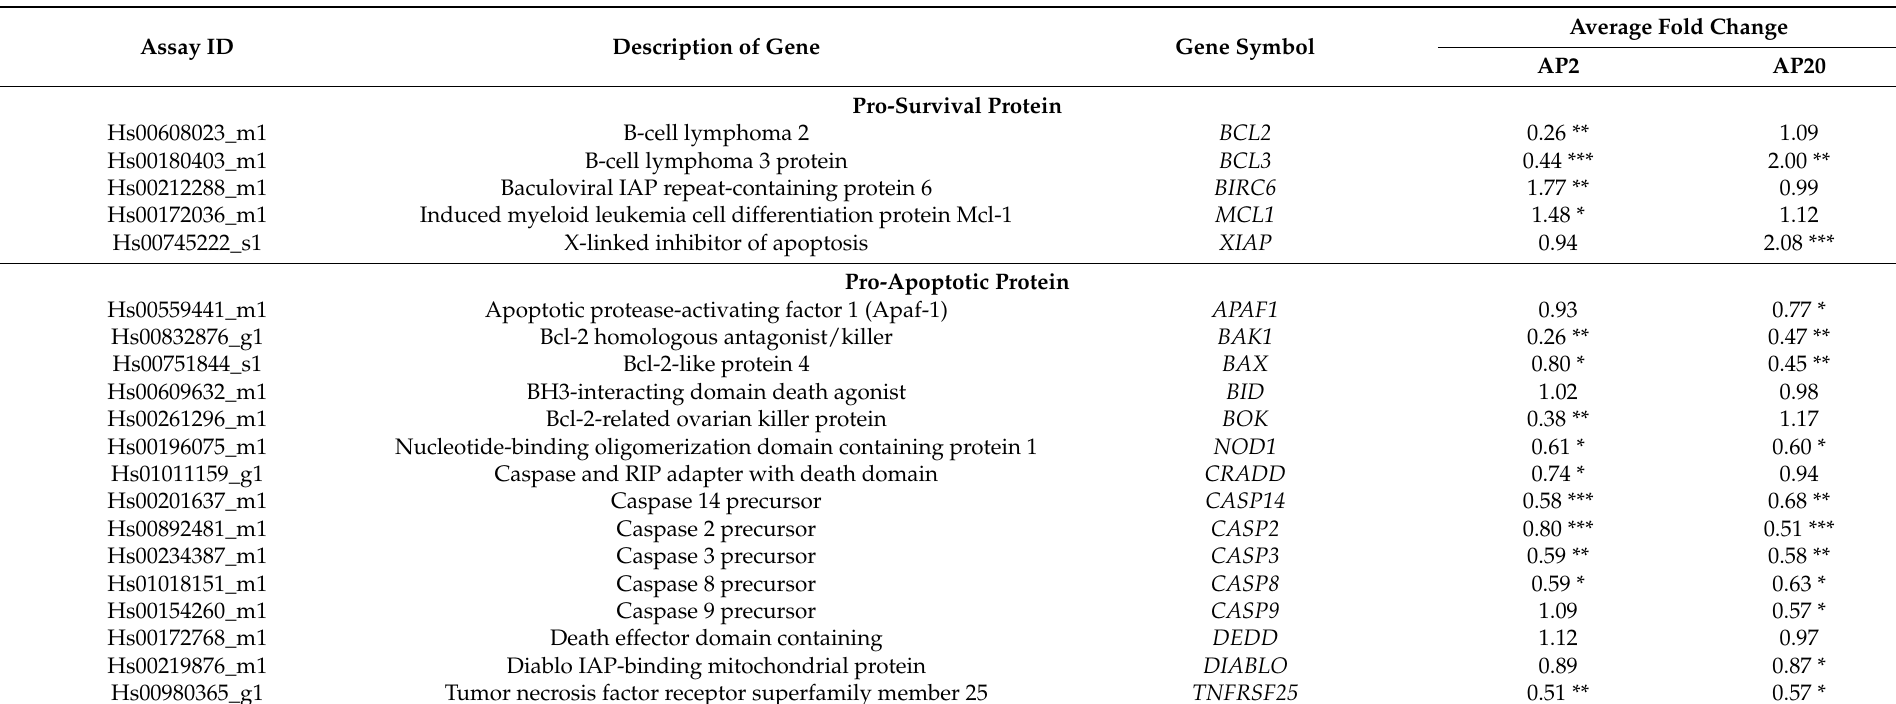
Table 1. Effect of apelin on mRNA expression of apoptotic factors in BeWo cells. The cells were incubated with apelin at doses 2 (AP2) and 20 ng/mL (AP20) for 24 h, after which real-time PCR analysis was performed. Experiments were independently performed and repeated minimum three times ( n =